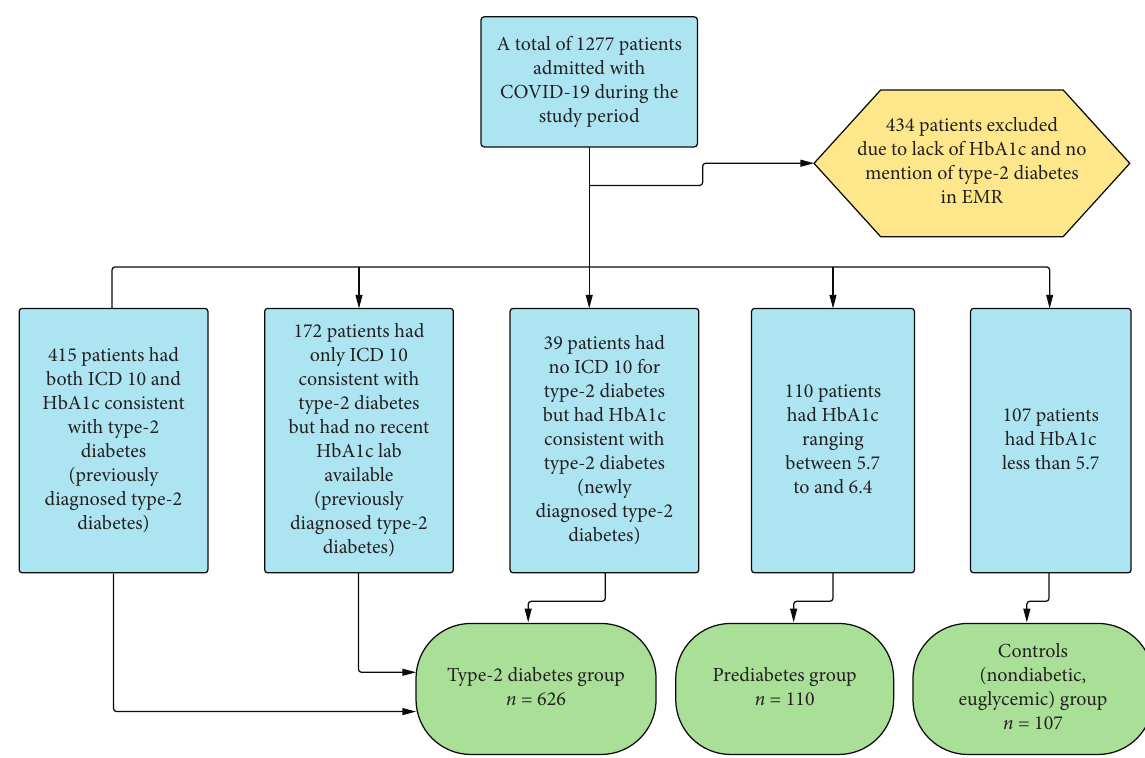
Figure 1: Flow diagram of patient